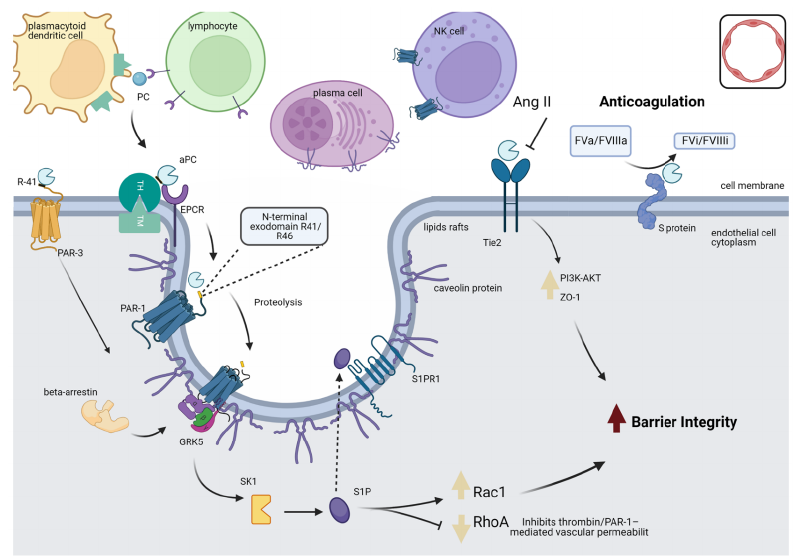
Figure 5. PC activation and signaling in the endothelial cell. When thrombin binds to TM on endo- thelial cell surfaces, PC is converted to its active form (APC), and EPCR is necessary for optimal PC activation. The co-localization of PAR-1 and EPCR in caveolin-1-rich membrane microdomains spe- cialized in the cell membrane is essential for PAR-1-mediated cytoprotective APC signaling. Fur- thermore, the heterogeneous expression of PC activation receptors (EPCR, THBD, CAV-1, and PAR- 1) in other cell populations suggests that PC activation might occur dynamically by zymogen PC interacting with ‘migratory’ receptors expressed on the su rfaces of infiltrating immune cells in the injury site. The anti-inflammatory and anticoagulant actions of APC occur mainly through PAR-1, which, when activated, propagates pro-inflammatory and anti-inflammatory responses according to the protease that cleaved it. PAR-1 is sensitive to proteolysis at its N-terminal exodomain by mul- tiple plasma proteases, including thrombin, APC, plasmin, factor VIIa, factor Xa, and matrix metal- loproteases. Cleavage of PAR-1 at the R41/46 sites at the N-terminal exodomain by APC initiates signaling, promoting structural reorganization of the receptor and coupling to the G protein com- plex (GRK-5) to phosphorylate the intracellular region of PAR- 1 and recruitment of β -arrestin 2, which serves as a framework for cytoprotective signaling. This cascade initiates a series of intracel- lular signaling pathways, including upregulation of SPHK1 activity and, therefore, S1P production, leading to activation of signaling through its S1PR1 receptor, which stimulates a marked increase in Rac1 activation to perform a protective barrier function by stabilizing the endothelial cytoskeleton and inhibiting RhoA signaling. The Tie2 receptor transmembrane domain can initiate downstream signaling pathways and maintain vascular integrity through direct APC binding, which results in increased ZO-1 phosphorylation of Akt via PI3K and ERK inhibition, contributing to increasing the integrity of the barrier. Protein S cofactor-linked APC can intervene at various points during the systemic response to infection. It exerts an antithrombotic effect by inactivating factors Va and VIIIa, limiting thrombin generation. Finally, PAR-3 cleavage by APC can initiate PAR1-dependent cyto- protective signaling in endothelial cells in the presence of EPCR. APC: activated protein C; EPCR: